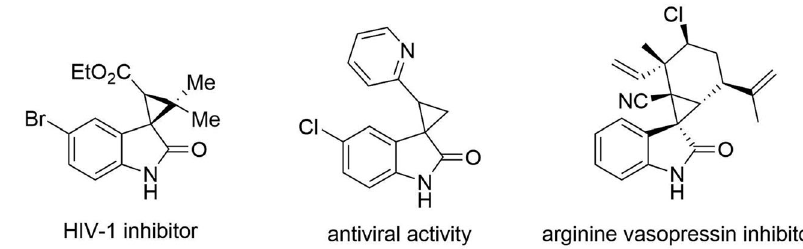
Fig. 2 Bioactive spirocyclopropyloxindoles. Three spirocyclopropyl oxindole compounds that have been shown to be biologically active.